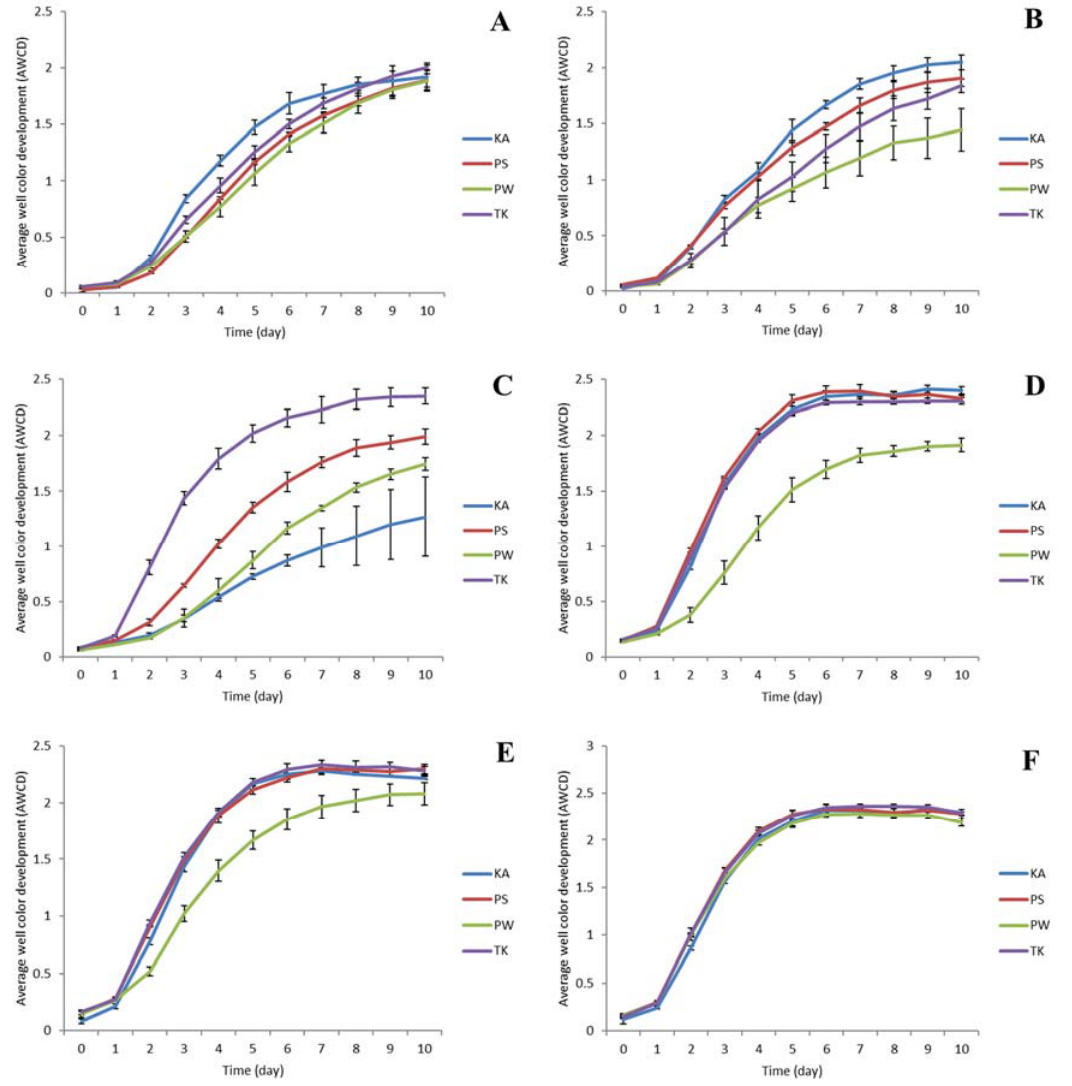
Figure 2. Changes of AWCD according to incubation time of rhizosphere soil microbes based on the growth stages (V2, R1, R3, R5, R7) of soybean. Values indicate mean ( n = 3) ± standard deviation. ( A ), Soil before planting soybean; ( B ), V2 stage; ( C ), R1 stage; ( D ), R3 stage; ( E ), R5 stage; ( F ), R7 stage.